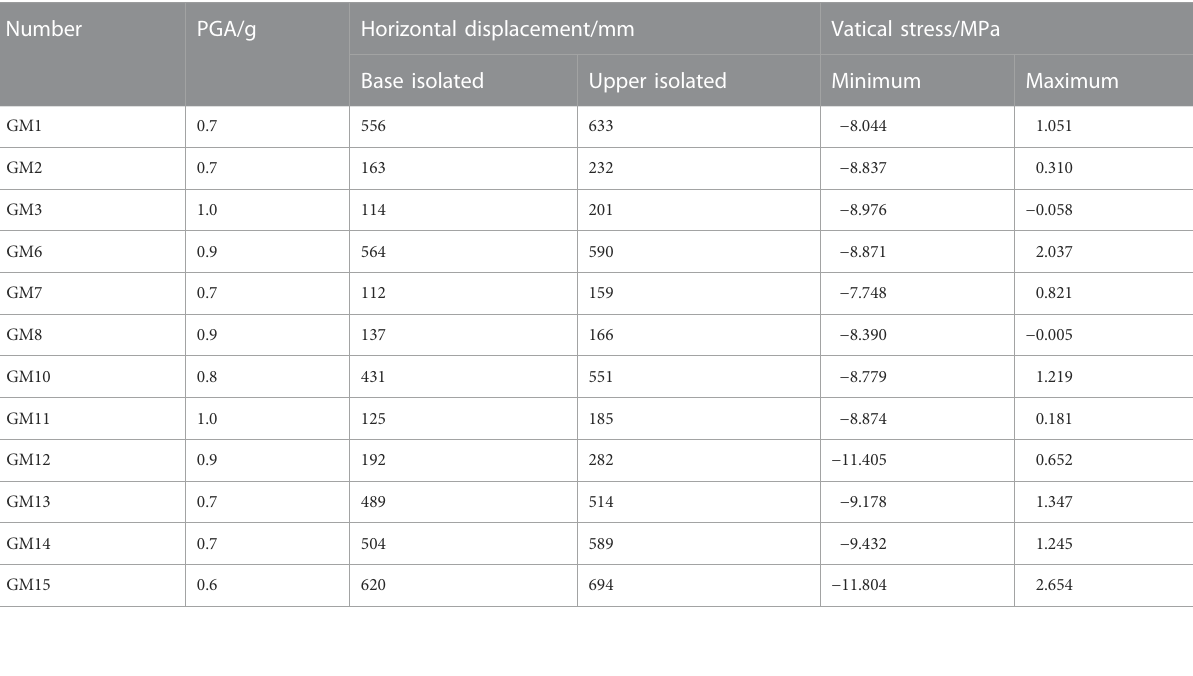
TABLE 5 Failure of major structure.